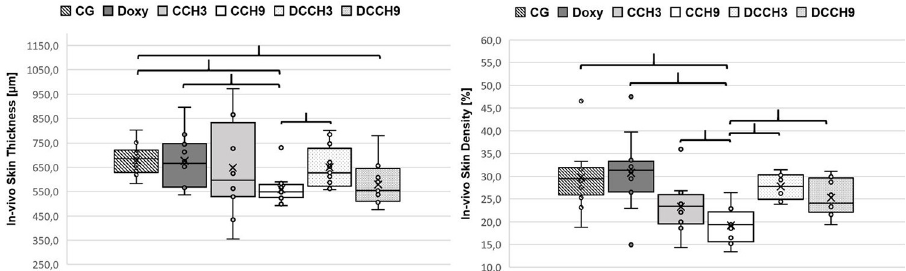
Fig 6. In-vivo results of skin measurements. left) skin thickness and right) skin collagen density measurements. Mean values (X) are graphed on a box plot and individual data points are shown. Density is measured as percentage of stained pixels in relation to the whole image pixel count. Brackets indicate statistically significant differences (p < 0.0083). Group size: n = 12.